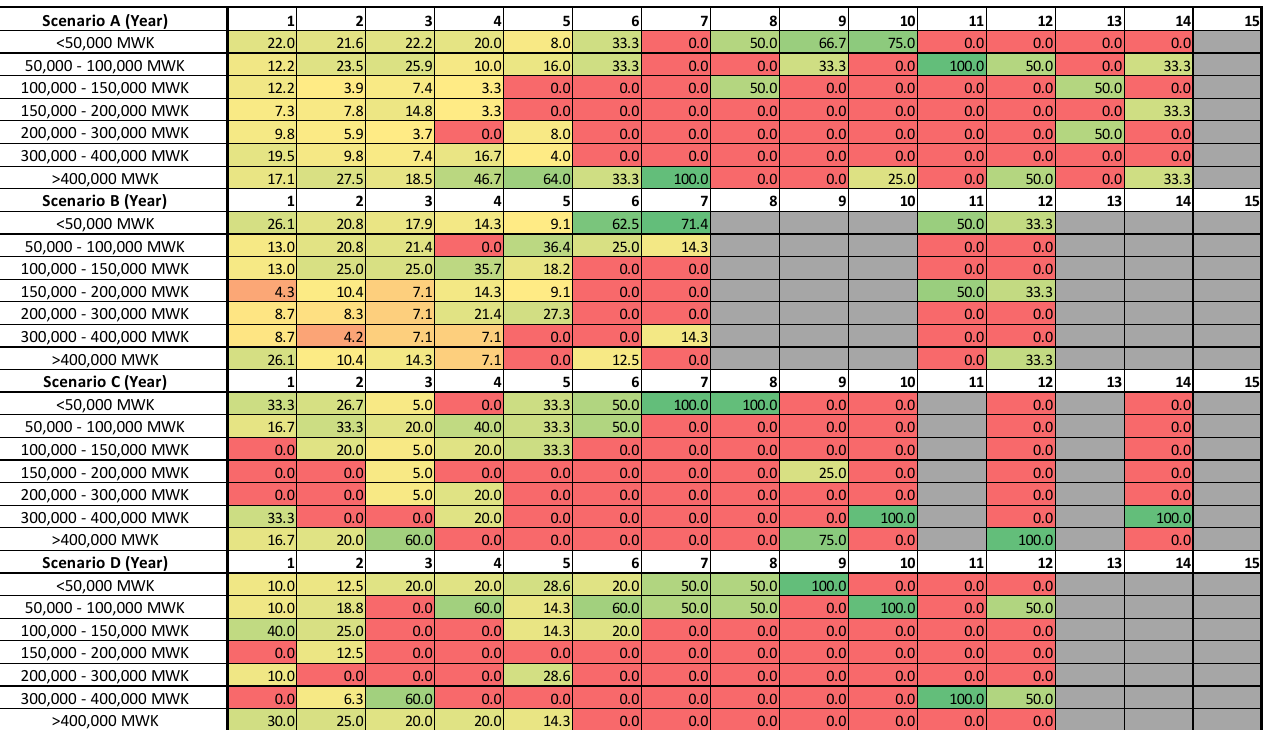
Figure 3. Heat map showing the percentage of total major repairs according to costs within each scenario for assets that have undergone rehabilitation.